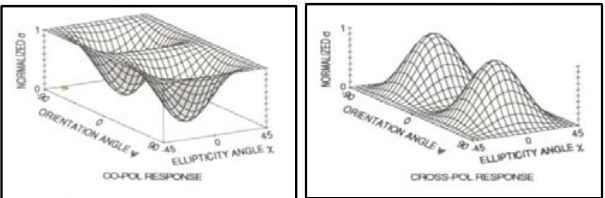
Figure 2.3a: Polarization Response of Dihedral corner reflector obtained “Radar Polarimetry for Geoscience Applications”